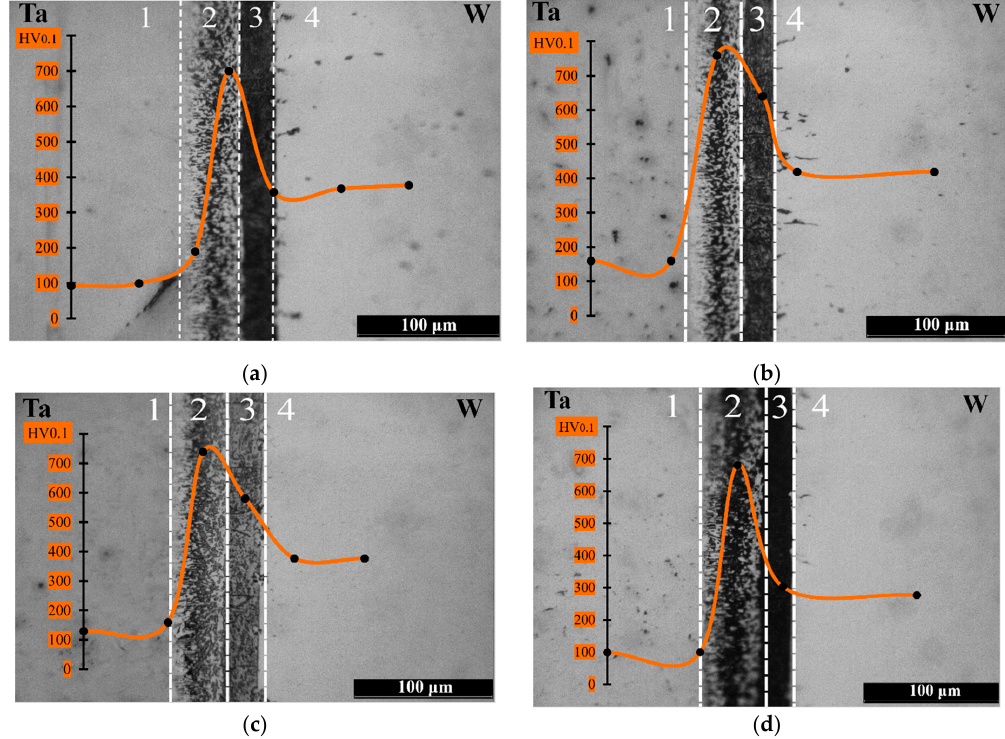
Figure 14. Optical image with microhardness profiles of Ta/ TiZr4Be/W seam after thermocycling test: ( a )—as-joined, ( b )—50 thermocycles, ( c )—100 thermocycles, ( d )—200 thermocycles.